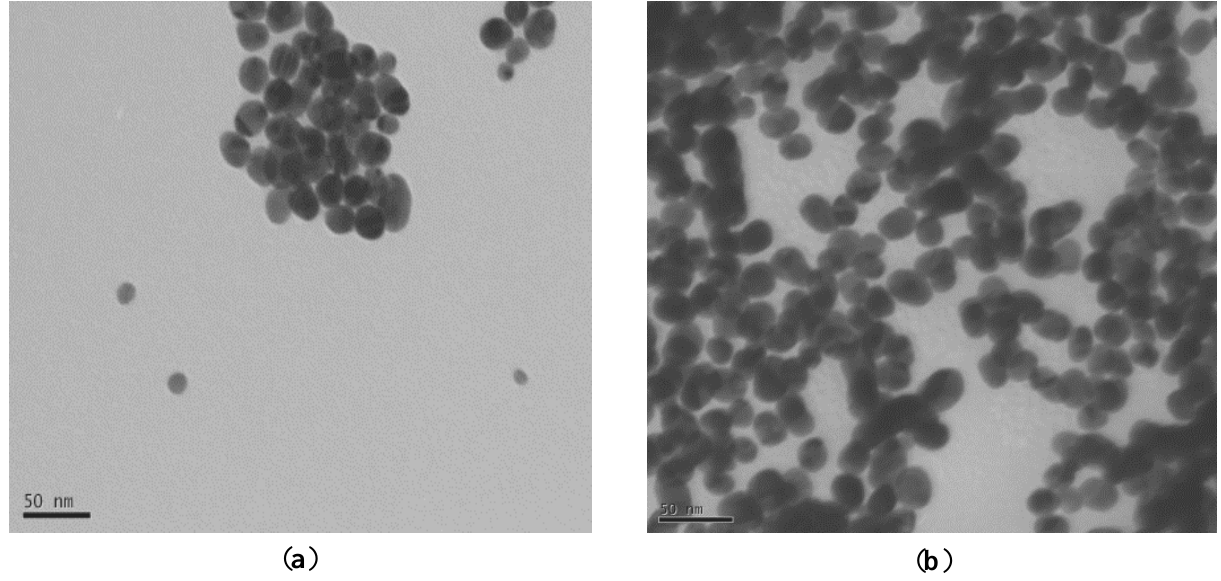
Figure 1. TEM images of gold nanoparticles without ( a ) and with ( b ) proteinase